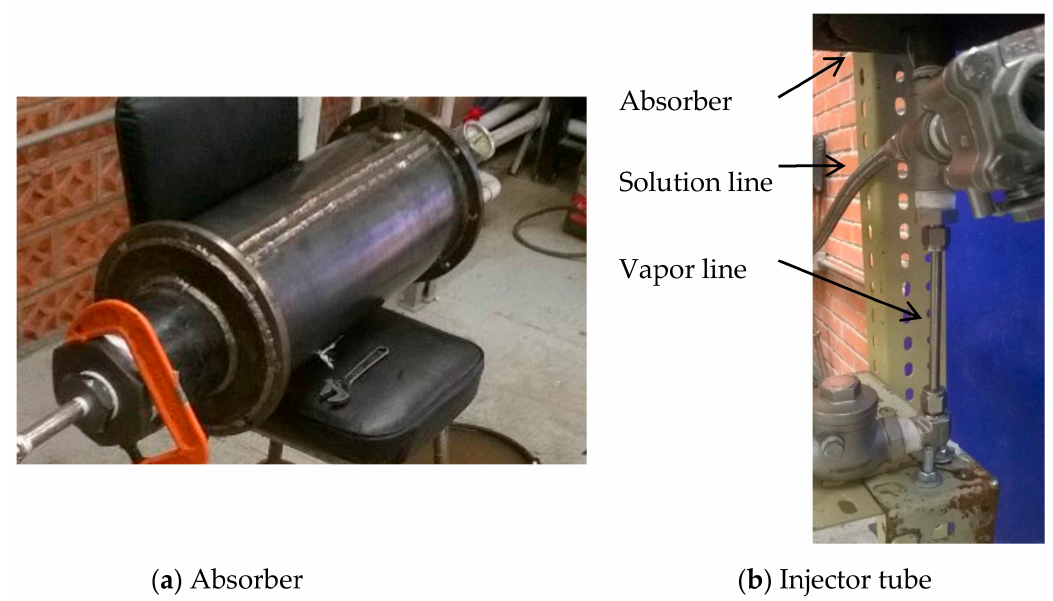
Figure 2. Double pipe heat exchanger ( a ) and vapor injection ( b ).